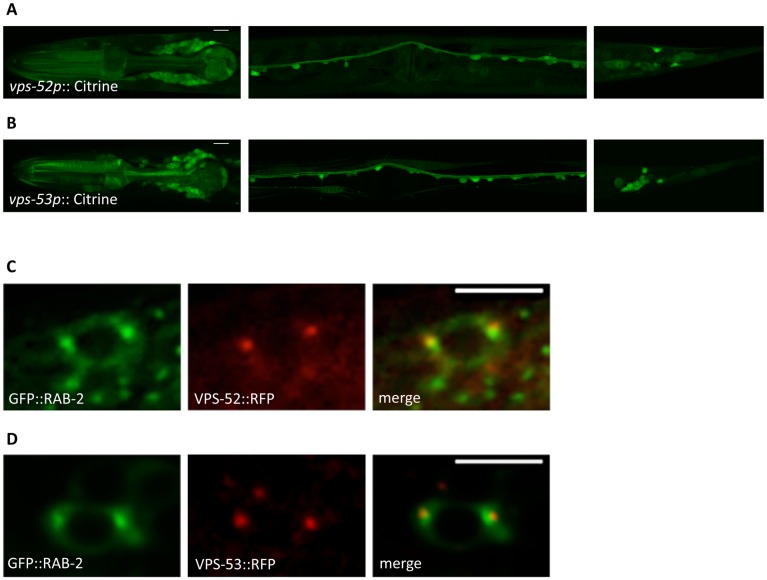
VPS-52 and VPS-53 are expressed in neurons and partially colocalize with RAB-2.(A) Representative images of animals expressing citrine under the vps-52 promoter (oxEx1445 transgene). The image on the left shows expression in the head neurons and pharynx, the image in the middle shows expression in ventral cord motor neurons and the image on the right shows expression in tail neurons. All images are single confocal slices of animals in a dorsal/ventral orientation. Scale bar: 10 μm. (B) Representative images of animals expressing citrine under the vps-53 promoter (oxEx1446 transgene). The image on the left shows expression in the head neurons and pharynx, the image in the middle shows expression in ventral cord motor neurons and the image on the right shows expression in tail neurons. All images are single confocal slices of animals in a dorsal/ventral orientation except the tail, which shows a lateral orientation. Scale bar: 10 μm. (C) Representative images of neurons coexpressing VPS-52::tagRFP and GFP::RAB-2 (oxSi192 and oxSi314 transgenes). Scale bar: 5 μm. (D) Representative images of neurons coexpressing VPS-53::tagRFP and GFP::RAB-2 (oxSi190 and oxSi314 transgenes). Scale bar: 5 μm.